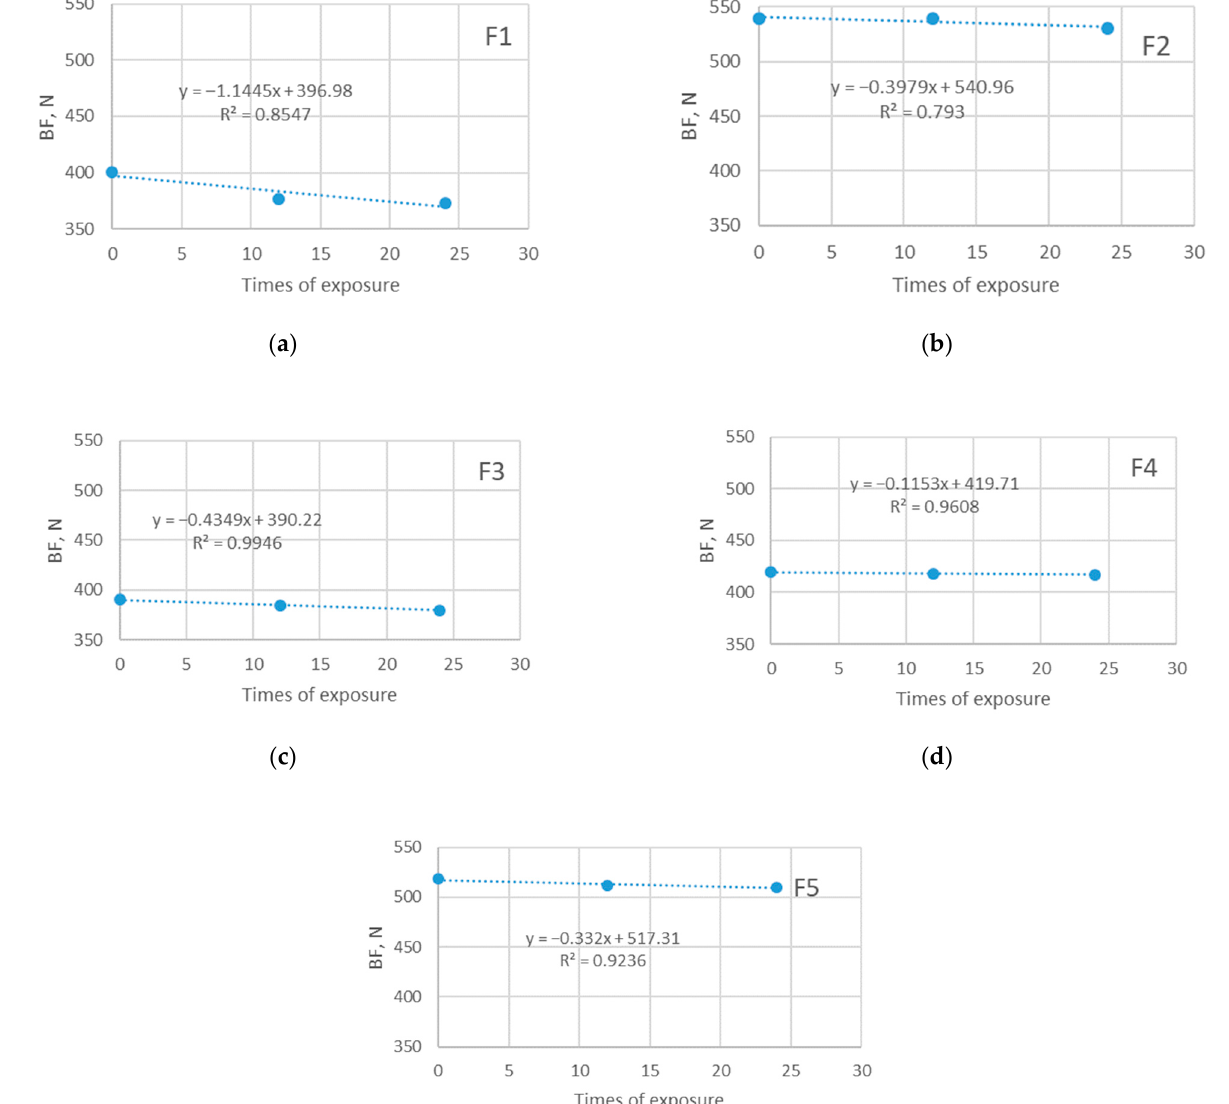
Figure 10. Bursting force (BF) of five investigated materials exposed in sun: ( a ) F1; ( b ) F2; ( c ) F3; ( d ) F4; ( e ) F5.